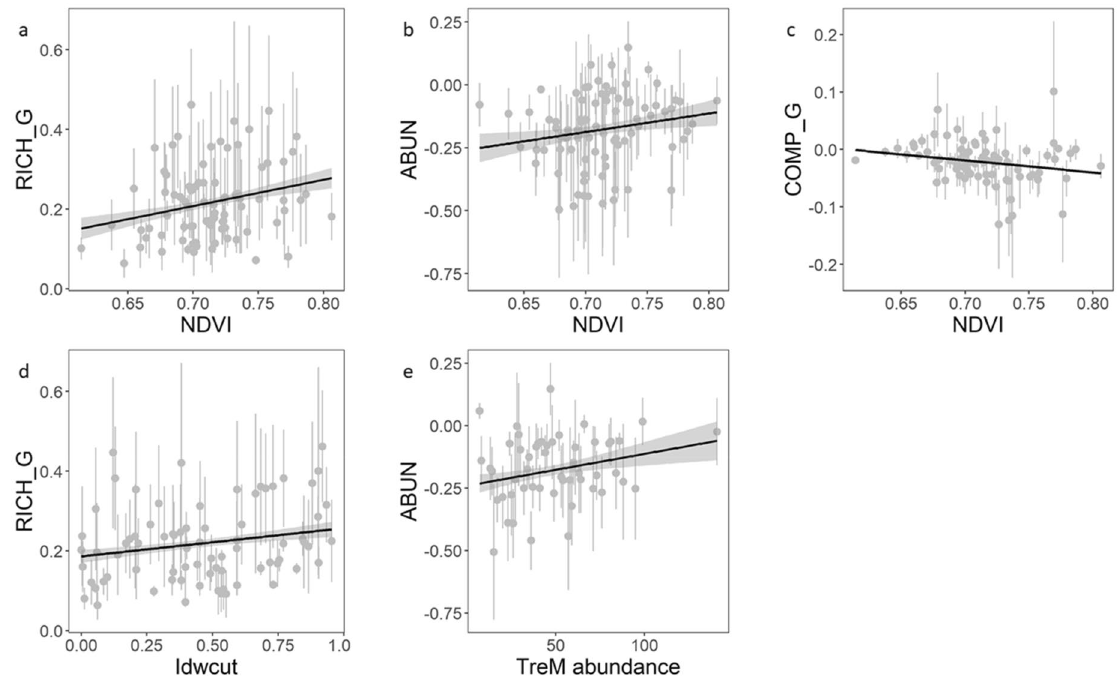
Figure 3. Significant effects of management and environmental variables on the Price components, describing the contribution of species assortment changes to functional diversity, resulted from linear mixed-effects models. The effects are modelled using FD_comb ( a , d , e ) and FD_strata ( b, c ) from bird assemblages across 82 forest sites. NDVI = Normalized Difference Vegetation Index; Idwcut = proportion of man-made versus natural deadwood; TreM = Tree-related